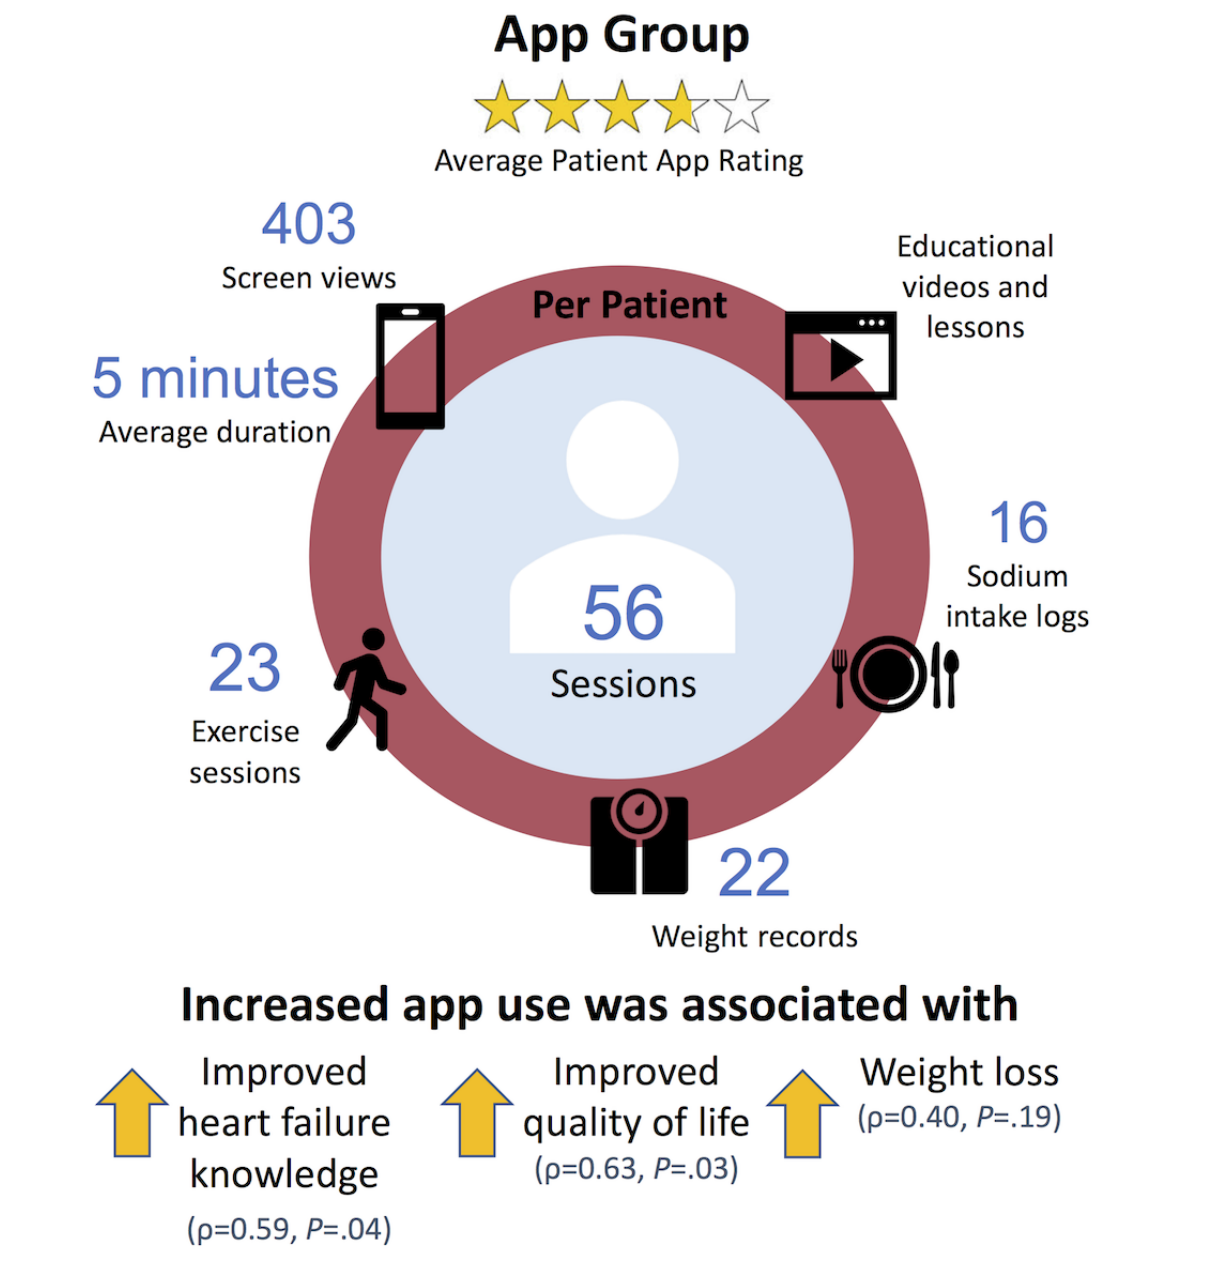
Figure 3. App feasibility and patient